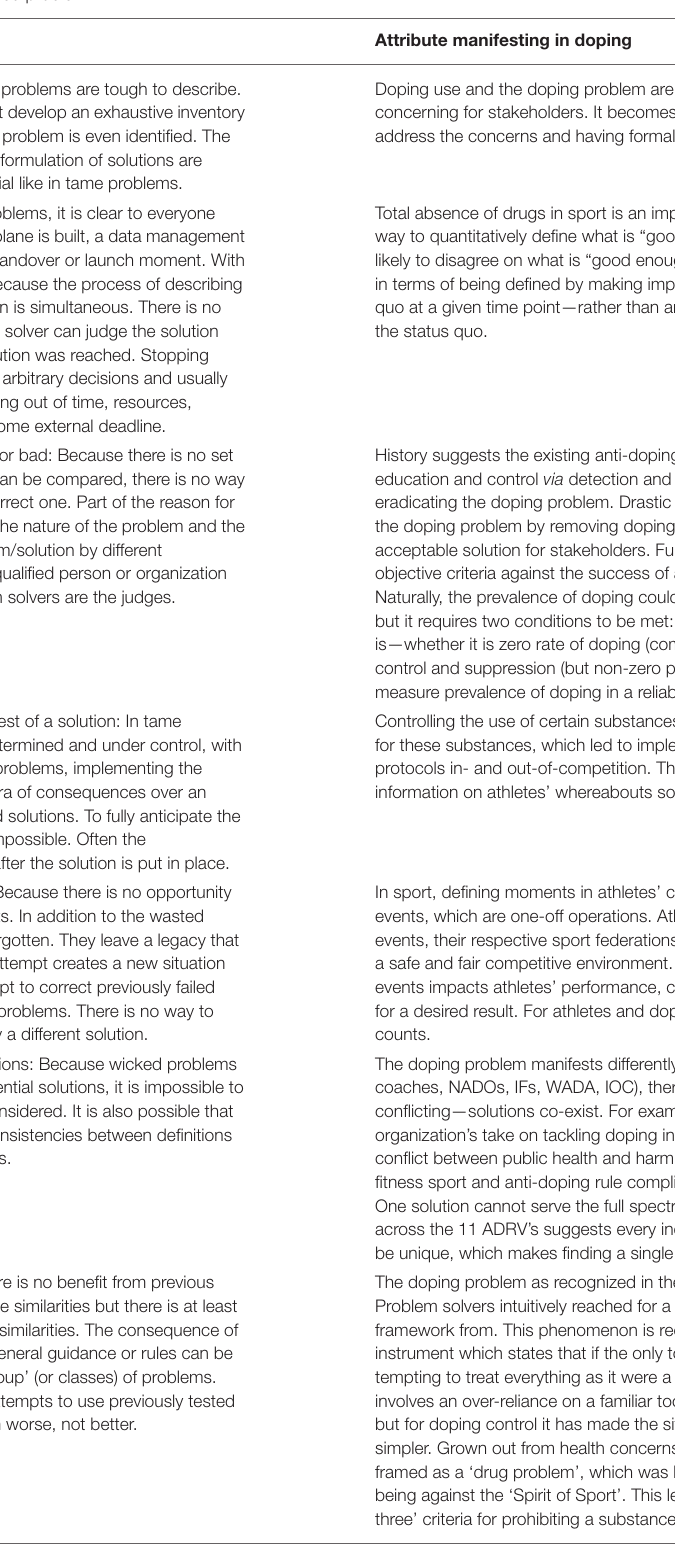
TABLE 1 | Characterizing doping as a wicked